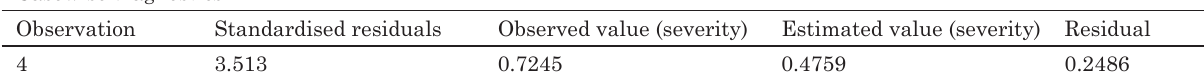
Table 5. Analysis of outliers (Casewise diagnostics) Casewise diagnostics